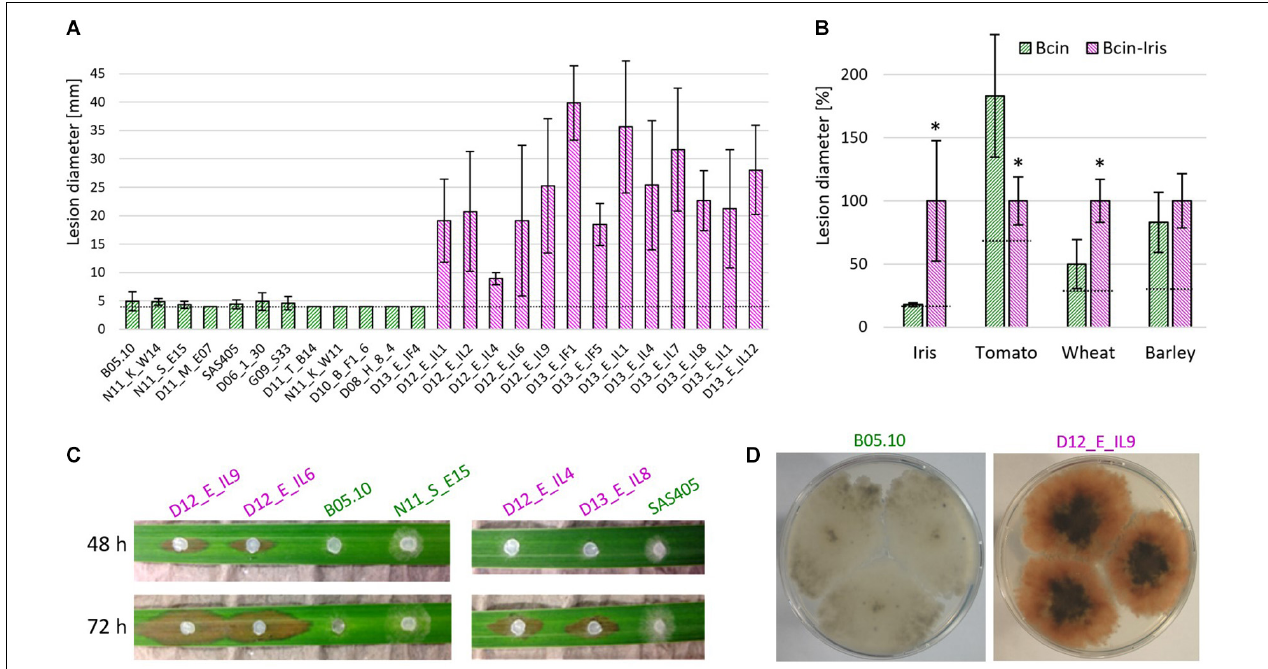
FIGURE 4 | B. cinerea Iris strains are highly aggressive on Iris pseudacorus leaves and produce the red pigment bikaverin. (A) Lesion development on detached leaves, 5 days after inoculation with 12 B. cinerea and 13 B. cinerea Iris strains. (B) Mean lesion sizes induced by B. cinerea (green) and B. cinerea Iris (pink; shown in A and Supplementary Figure 4 ) on leaves of different plant species. The dotted lines indicate the average sizes of the inoculation droplets. Values for B. cinerea and B. cinerea Iris were compared by unpaired t -test. * p < 0.001. n.s.: not significant. (C) Symptoms on I. pseudacorus leaves induced by different B. cinerea strains. (D) Pictures of colonies of gray B. cinerea (left) and pink B. cinerea Iris (right)